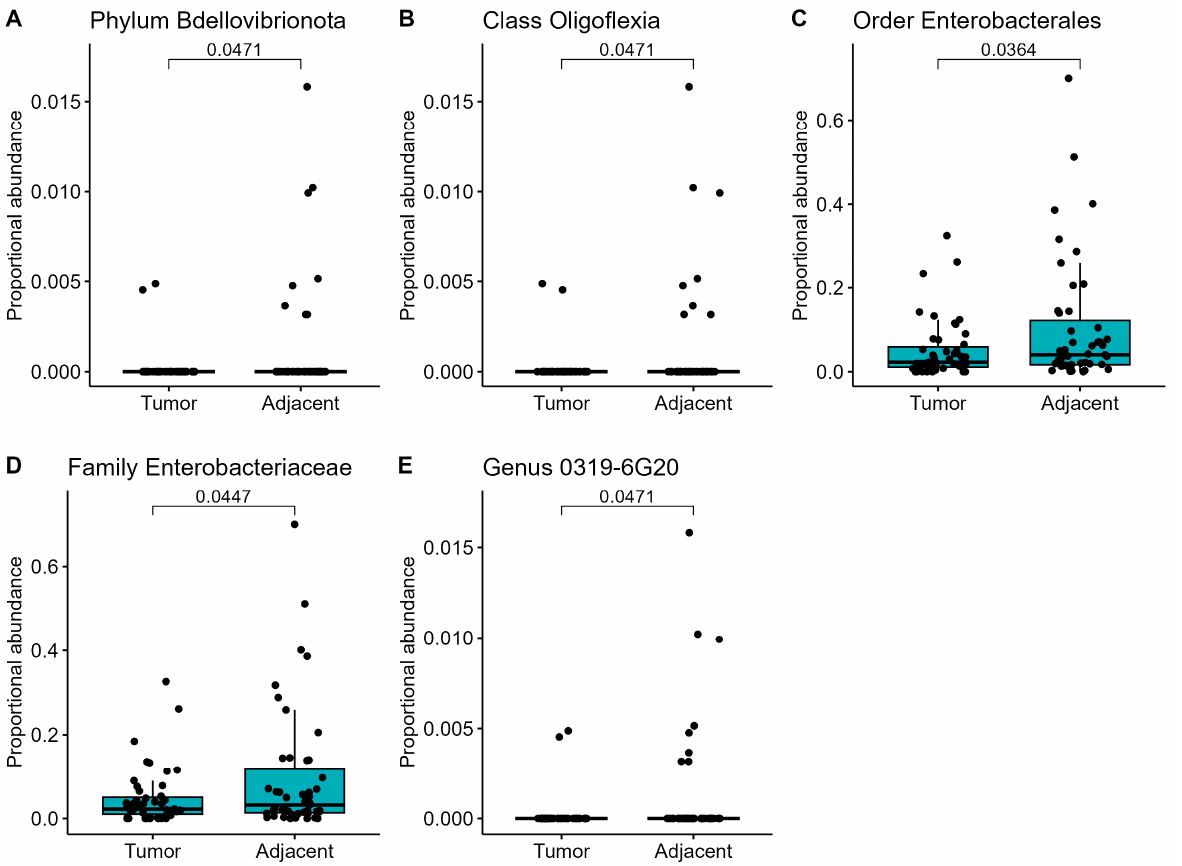
Figure 3. ( A – E ) Individual differences in proportional abundances of the most significantly altered microbial communities between adjacent and breast tumor tissues at different levels. A p < 0.05 is considered statistically significant based on t-test measurements.